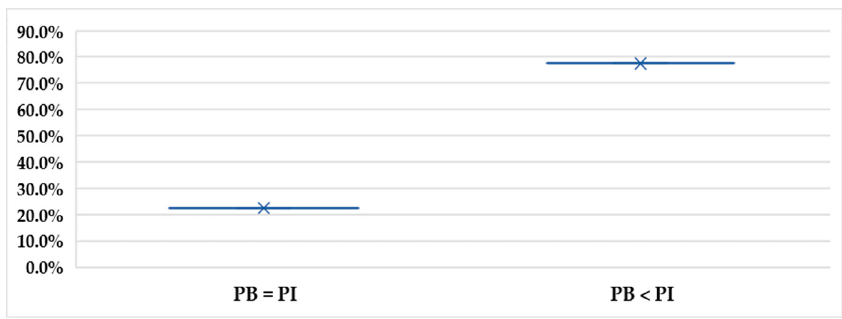
Figure 7. The percentage of the consumers who hold purchase intentions (PI) equal to their purchase behavior (PB), and consumers who hold PI higher than their PB.